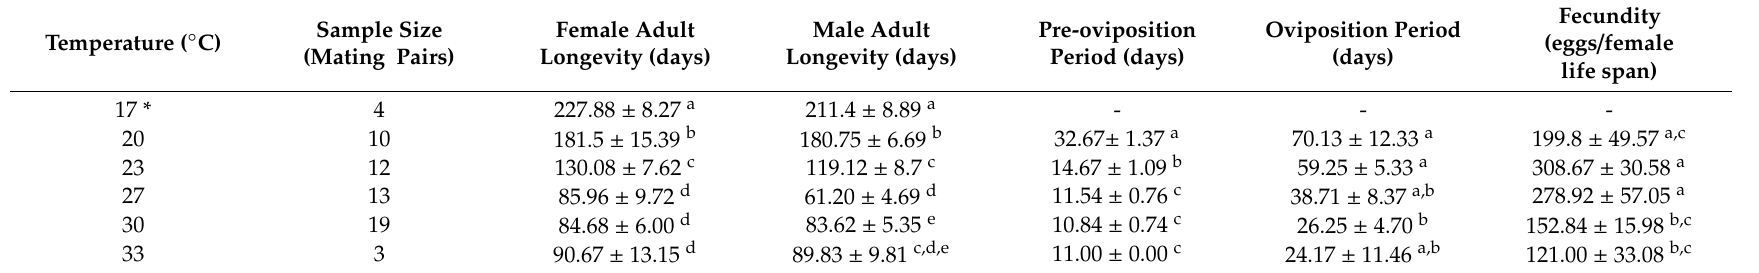
Table 2. Temperature-dependent adult longevity, pre-oviposition period and fecundity for H. halys .